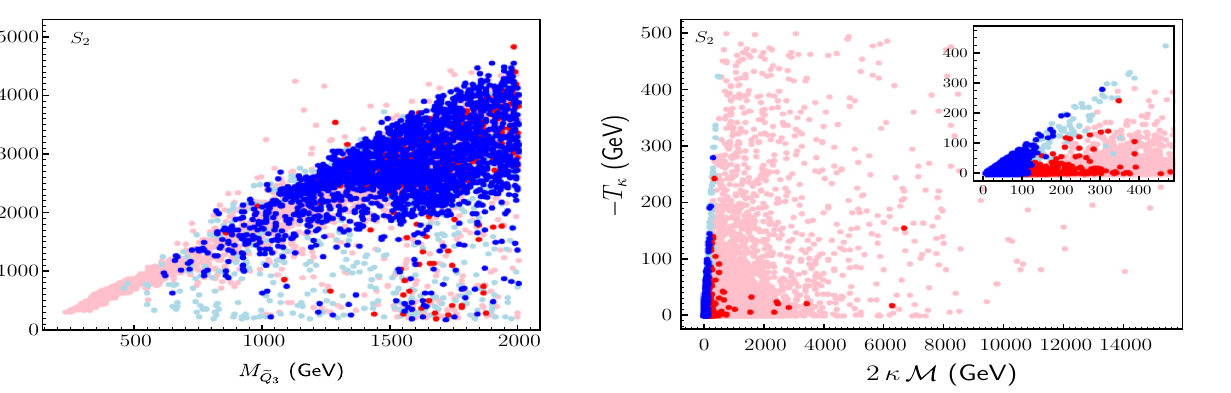
5.1.3 Scan 3 ( 0 . 5 ≤ λ < 1 . 2 )